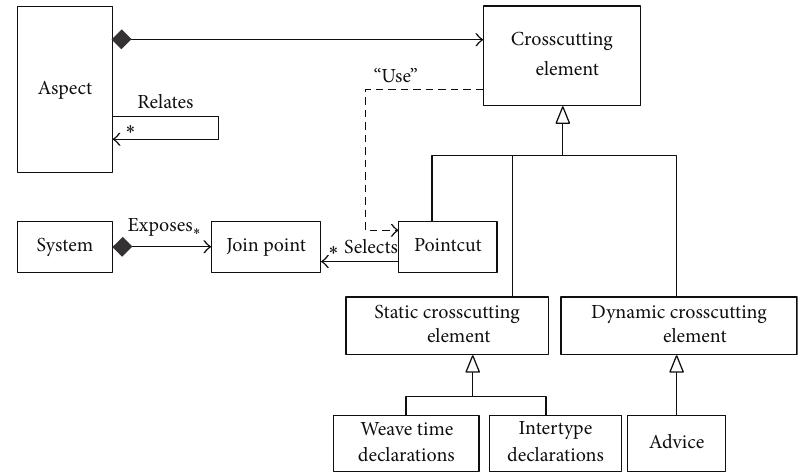
Figure 2: Generic model of an AOP system